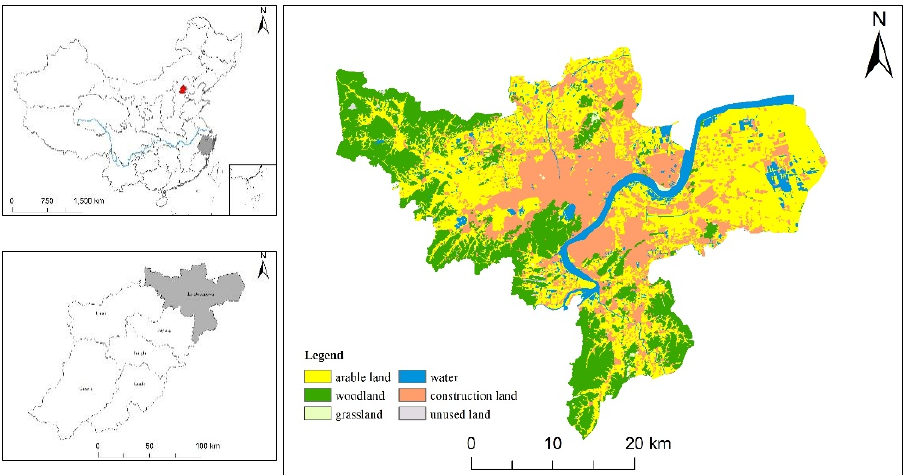
Figure 1. Location of the study area.